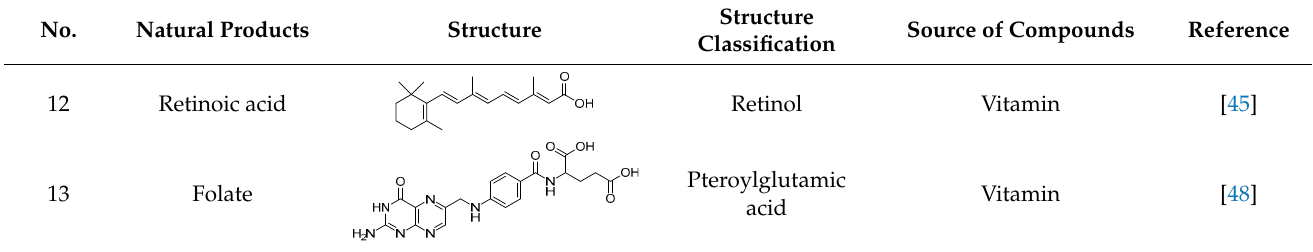
Table 5. Natural products 12–13.